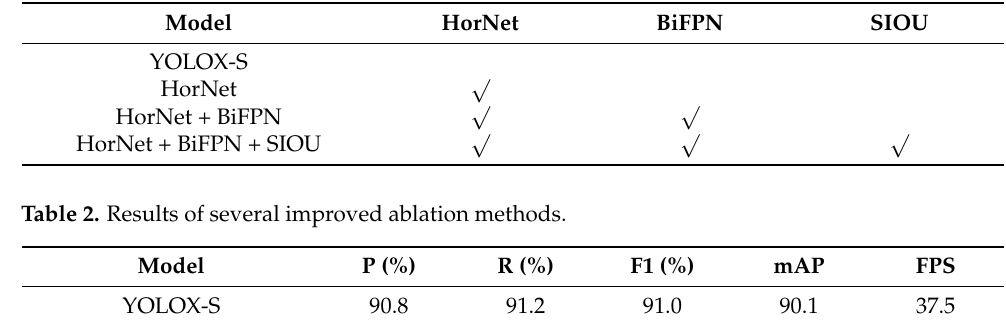
√ ” indicates the selected module.